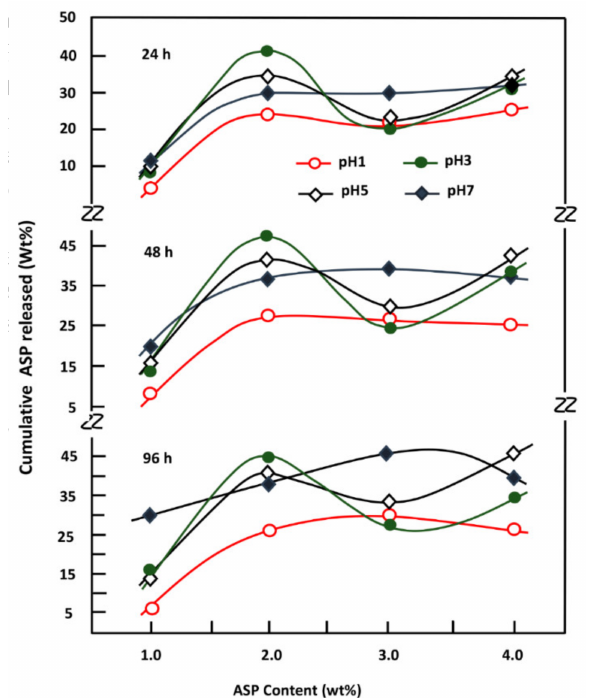
Figure 13. Variation of the cumulative ASP released from the ASP-2/PE- co -VAL/P δ -VL drug carrier system in different media pHs versus the ASP content and at different